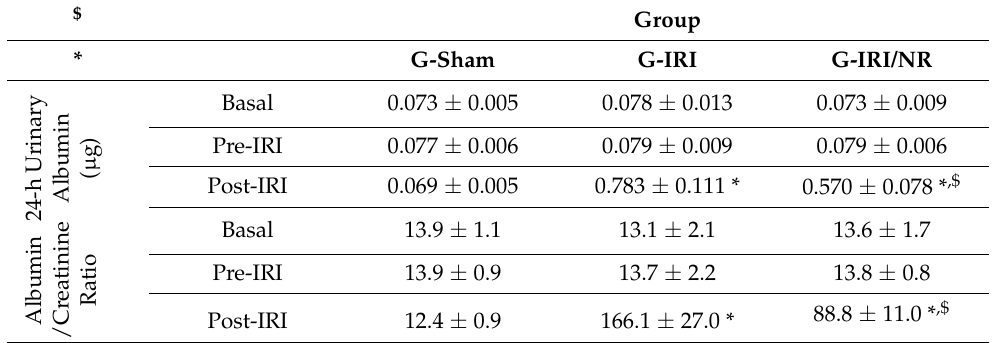
Table 3. The 24 h urinary albumin and albumin/creatinine ratio in all groups before administration of the nerolidol/vehicle (basal values), after administration of the nerolidol/vehicle, just before the ischemia–reperfusion injury (Pre-IRI) and on the third day following IRI (Post-IRI). * Indicates statis- tical significance compared to the Pre-IRI within the same group; $ indicates statistical significance compared to the G-IRI group. Values are expressed as mean ±